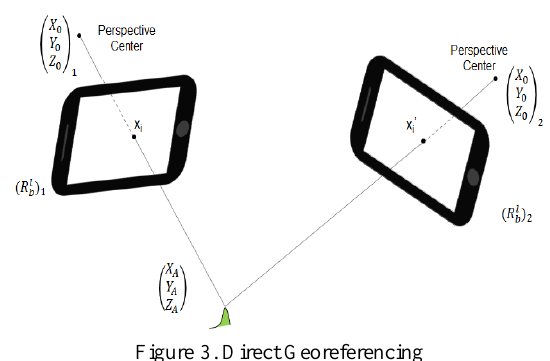
Figure 3. Direct Georeferencing